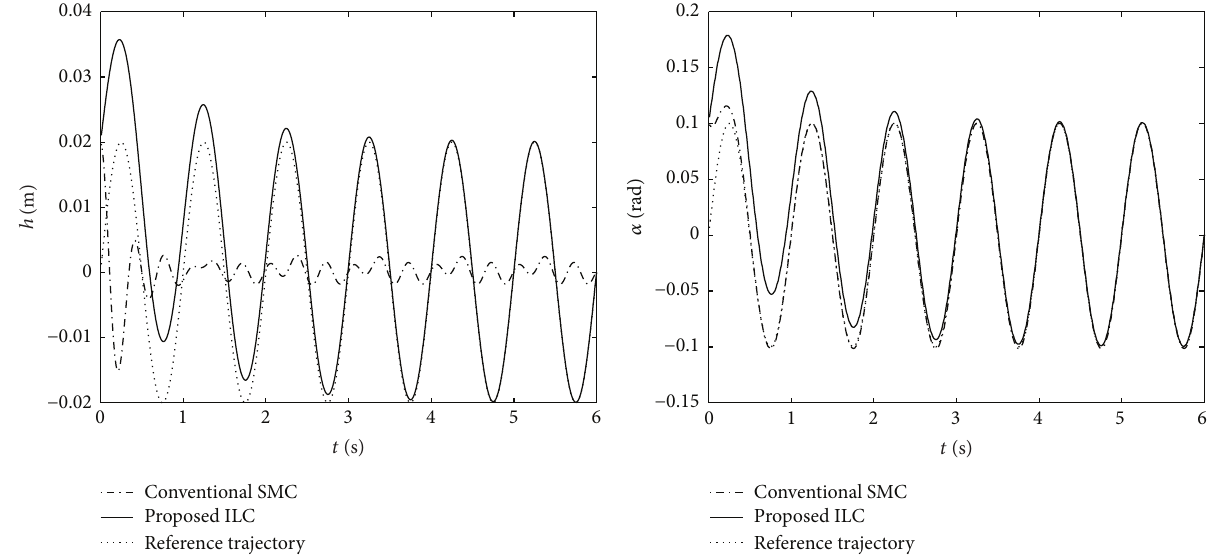
Figure 9: Comparison of the tracking response when 𝑥 ℎ,𝑑 = 0.02 sin (2𝜋𝑡) , 𝑥 𝛼,𝑑 = 0.1 sin (2𝜋𝑡) .